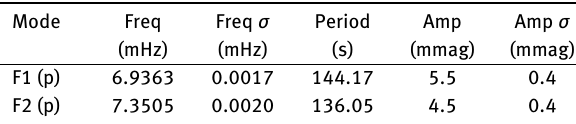
Table 2. Pulsation peak frequencies of PG 1613+426. All data was used to obtain the frequencies.